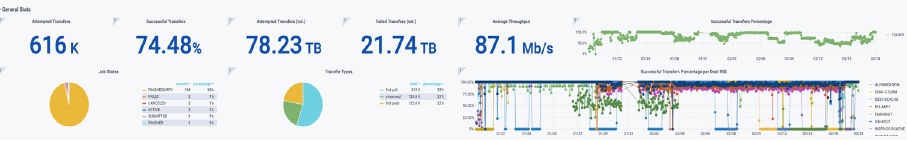
Figure 4: FTS transfers dashboard (general stats view - 1 month)